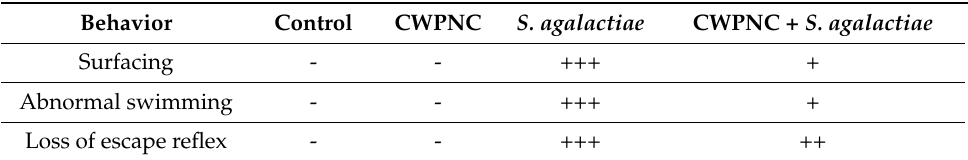
Table 3. Effect of exposure to 3 mg/L CWPNC on behavioral responses of O. niloticus infected with S.